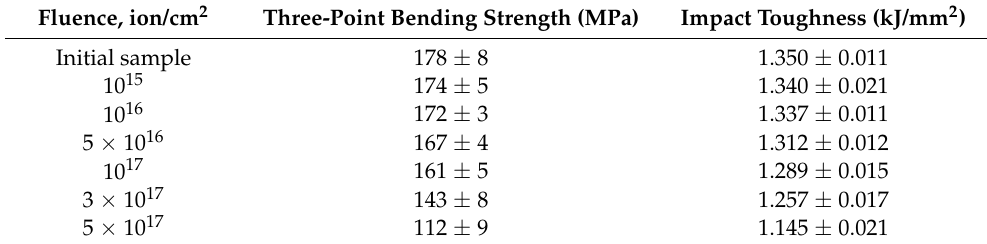
Table 3. Data of strength characteristics.